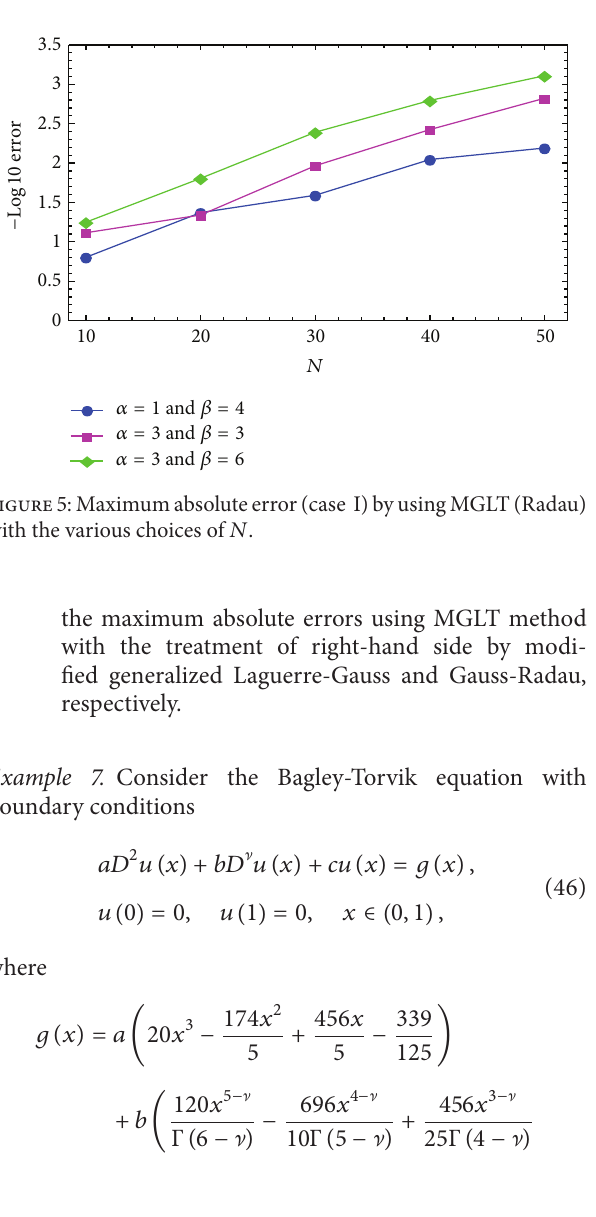
Figure 4: Maximum absolute error (case I) by using MGLT (Gauss) with the various choices of 𝑁 .